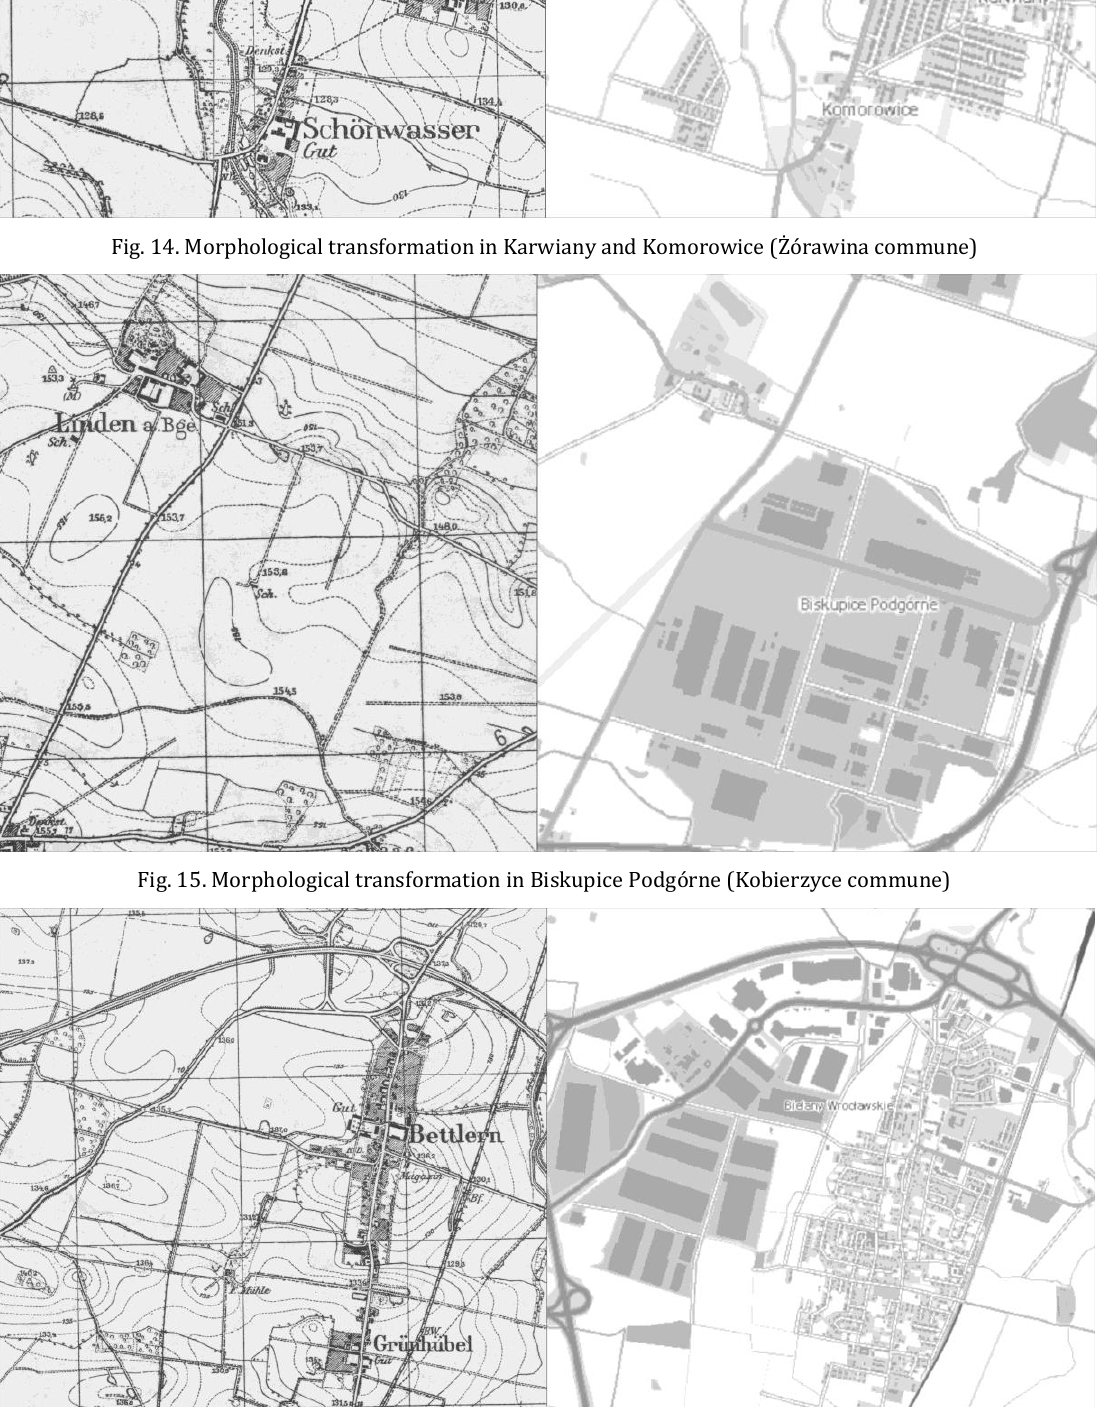
Fig. 16. Morphological transformation in Bielany Wrocławskie (Kobierzyce